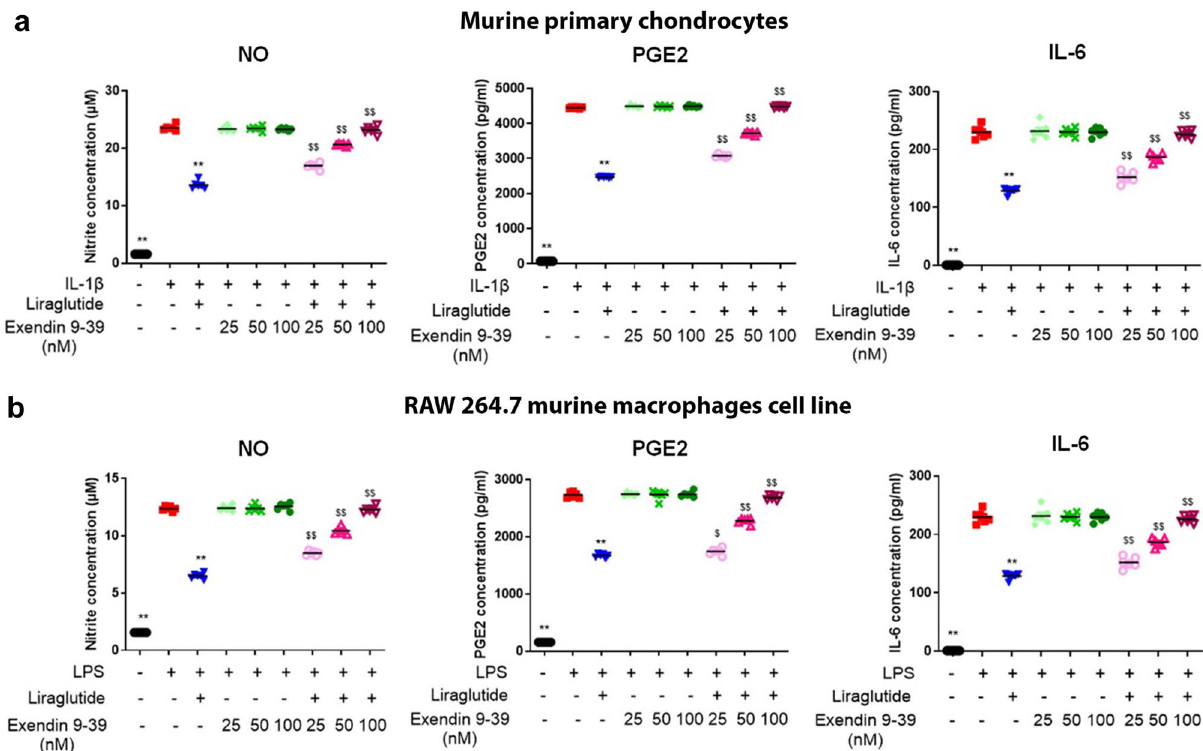
Figure 6. Anti-inflammatory effects of liraglutide are mediated by the GLP-1 receptor pathway. Primary cultured murine articular chondrocytes were incubated with 2 ng/mL IL-1β ( a ) and RAW 264.7, which were incubated with 100 ng/mL LPS ( b ) and co-treated with 50 nM of liraglutide or co-treated with three doses of exendin fragment 9–39 (25 nM, 50 nM, and 100 nM) for 24 h (n = 6). Nitrite, PGE 2 , and IL-6 concentration of the supernatant was determined. Statistical analysis: Mean ± SEM, Mann–Whitney test with sequential strategy, ** p < 0.01, versus stimulated control (IL-1β or LPS) and $ p < 0.05, $$ p < 0.01, versus IL-1β + liraglutide or LPS + liraglutide